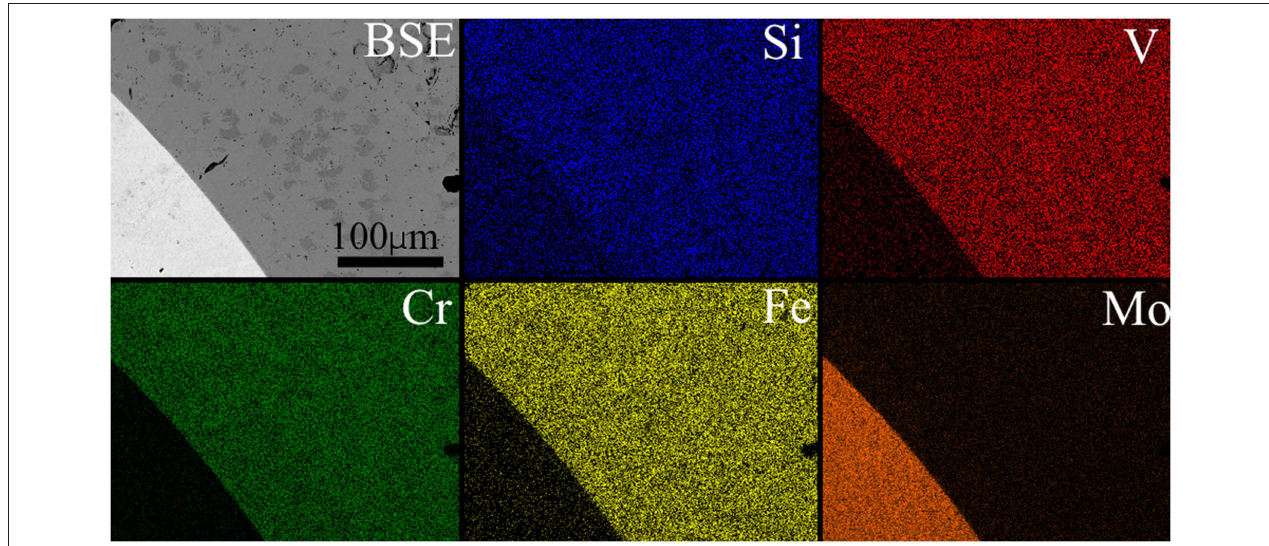
FIGURE 7 | Lower magnification backscattered electron image of as-cast SiFeVCrMo, with elemental maps showing the special distribution of